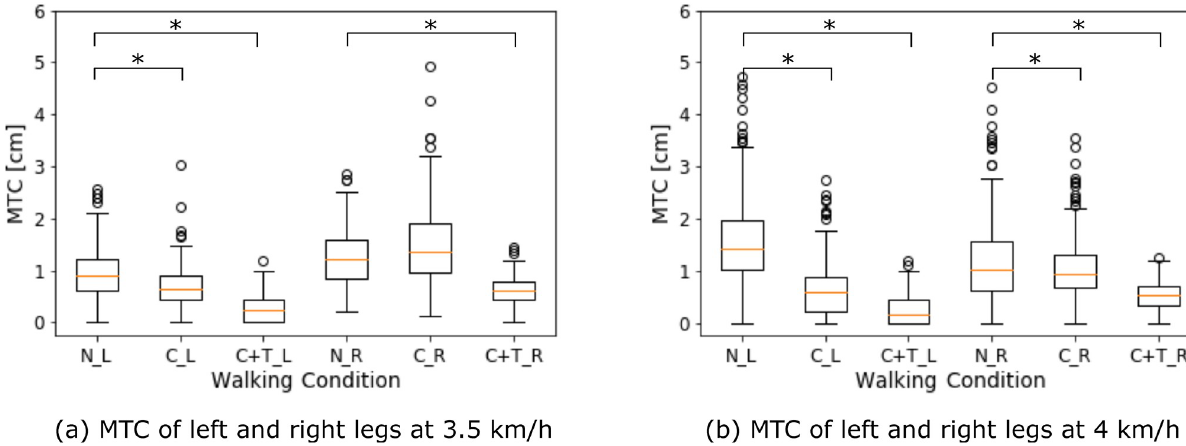
Fig 4. MTC median and variability (IQR) of a representative subject. The general tendency of the MTC of the subjects during restricted walking (C = C-restriction case, C + T = CT-restriction case) included a lower MTC median and IQR, compared to normal walking (N), for both right (R) and left (L) legs. � p < 0.01 indicates a significant lower MTC median compared to normal walking. The edges of the box plot correspond to the 25-th and 75-th percentiles, and the single points (outliers) correspond to the MTC values that were distant from the general tendency.